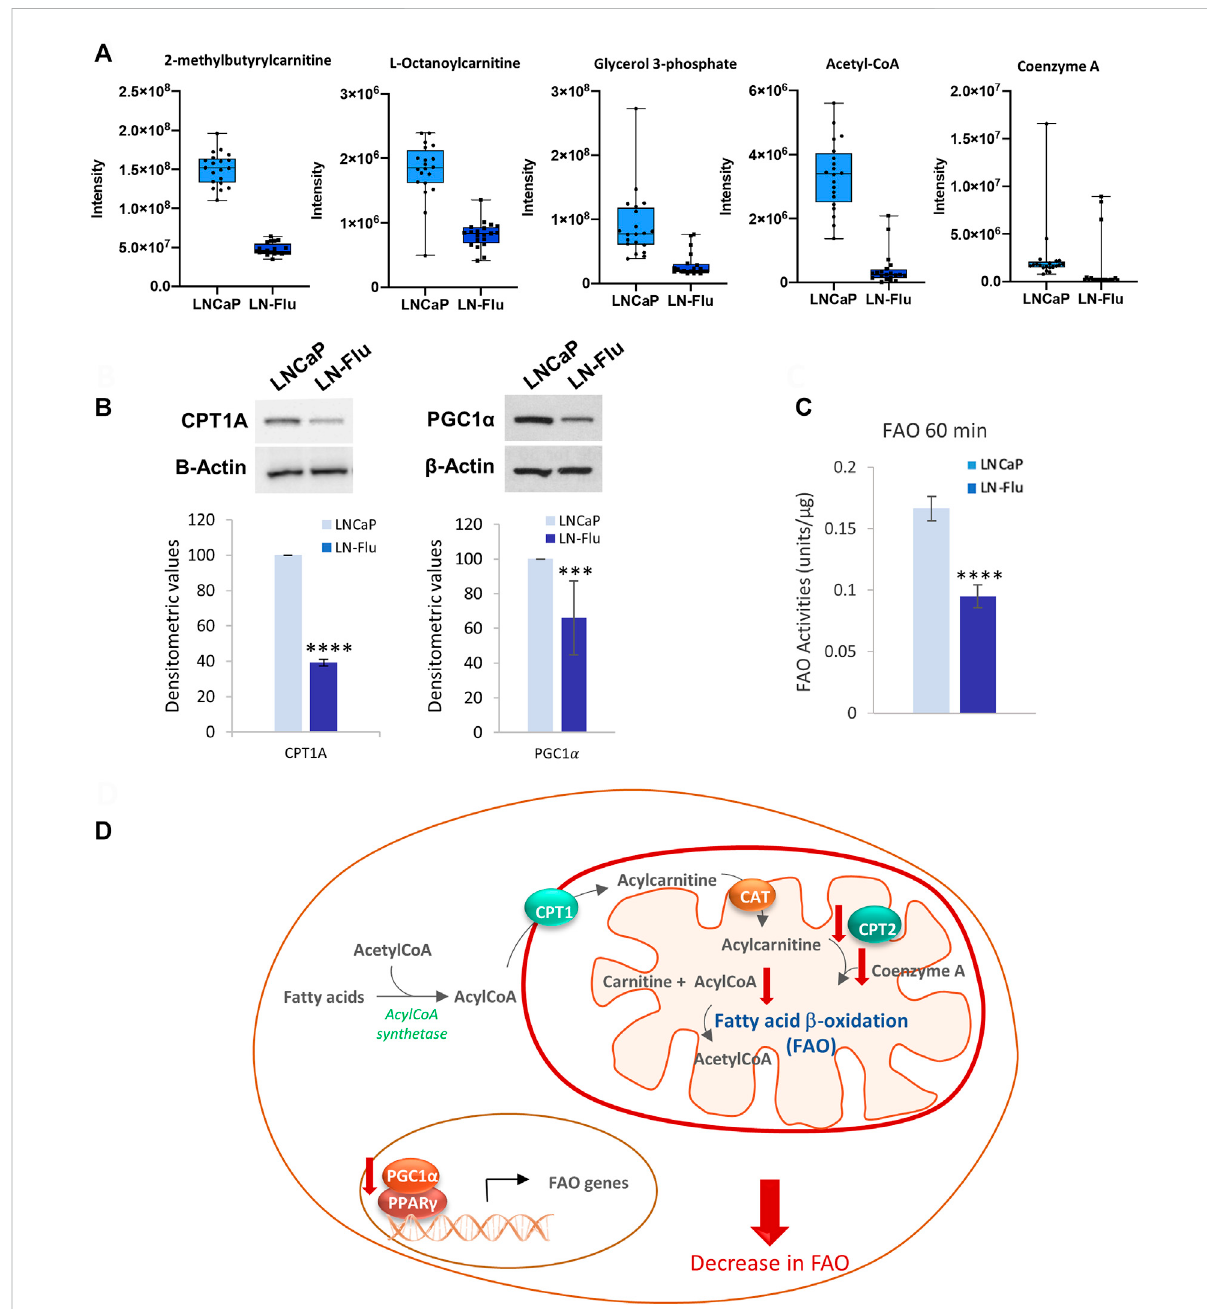
FIGURE 5 Fatty acid β -oxidation in prostate LN-Flu cells. (A) Box and whisker plot of metabolites involved in the pathway. (B) Levels of carnitine palmitoyl transferase 1 (CPT1) and Peroxisome proliferator-activated receptor-gamma coactivator 1 α (PGC1 α ) determined by Western blot. Densitometric analysisofthewesternblotbandsfromthreeindependentexperimentsisshownontheright. (C) Fattyacid β -oxidationdeterminedbyResultsarethe mean ± S.D. of three independent experiments. ** p < 0.01 signi fi cant difference between LNCaP and LN-Flu cells by two-way ANOVA and Sidak ’ smultiplecomparisonstest. (D) Fattyacid β -oxidation(FAO)schemeshowingthemetabolitesandenzymeswehavefoundup(redarrowup)or down (red arrow down) in LNFlu cells compared to LNCaP cells. CPT1, carnitine palmitoyltransferase 1; CAT carnitine:acylcarnitine translocase; CPT2, carnitine palmitoyltransferase 2; PGC1 α , peroxisome proliferator-activated receptor-gamma coactivator 1 α ; PPAR γ , peroxisome proliferator- activated receptor γ